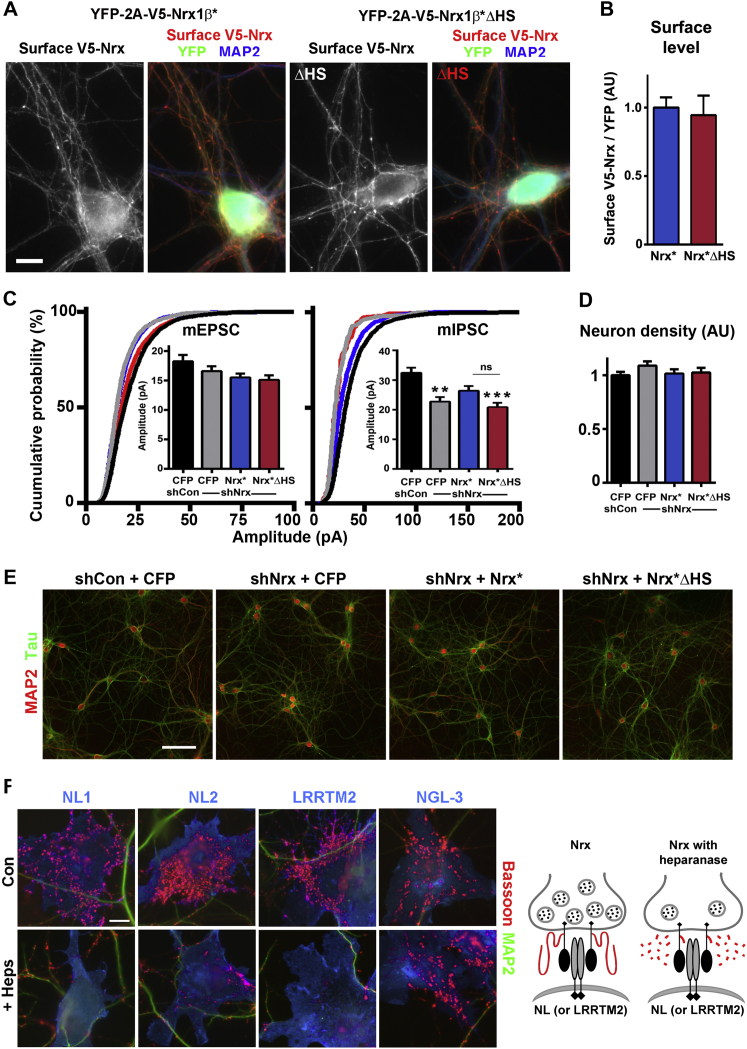
Nrx HS Modification Does Not Affect Nrx Surface Trafficking or Neuron Survival, and Heparinase Reduces Presynaptic Differentiation, Related to Figures 2 and 3(A) Nrx1β∗ΔHS reaches the axon surface, like Nrx1β∗, as shown by surface labeling of the V5 tagged Nrx constructs co-expressed with YFP through a 2A peptide. Note that both Nrx1β∗ and the ΔHS mutant are primarily axonal as MAP2 positive dendrites show little V5 fluorescence.(B) The axon surface level of Nrx1β∗ΔHS was indistinguishable from that of Nrx1β∗. Ratios of surface V5 to total YFP were assessed along axons of 13 DIV neurons co-expressing the V5 tagged Nrx constructs with YFP linked through the 2A peptide. A Mann-Whitney test showed no significant difference, n = 21-22 cells from 2 independent experiments.(C) mEPSC amplitude was not significantly different among groups (p = 0.0591). The numbers of cells were: CFP+shCon (n = 21); CFP+shNrx (n = 32); Nrx∗+shNrx (n = 29); Nrx∗ΔHS+shNrx (n = 32) from 4 independent experiments. mIPSC amplitude was reduced by Nrx knockdown and partially rescued by RNAi-resistant Nrx∗ but not Nrx∗ΔHS. The numbers of cells were: CFP+shCon (n = 20); CFP+shNrx (n = 18); Nrx∗+shNrx (n = 18); Nrx∗ΔHS+shNrx (n = 18) from 3 independent experiments. ∗∗p < 0.01 and ∗∗∗p < 0.001 by Kruskal-Wallis and Dunn’s tests compared to shCon+CFP. For the experiments shown here and in Figure 2, neurons were transfected at plating with the rescue constructs, exposed to knockdown AAV vectors from 3 DIV and analyzed at 13 DIV (mIPSCs) or 14 DIV (mEPSCs).(D and E) Hippocampal neuron cultures immunolabeled for MAP2-positive dendrites and tau-positive axons appeared similar among all groups. Neuron density assessed as number of MAP2-positive neurons per coverslip area normalized to the shCon+CFP group did not differ among groups by Kruskal-Wallis, n = 30 from 3 independent experiments. Neurons analyzed here were from the same experiments as for Figures 2, 3D-3E and panel C in this figure. Neurons were transfected at plating with the rescue constructs, exposed to knockdown AAV vectors from 3 DIV and analyzed at 14 DIV.(F) Clustering of presynaptic marker bassoon in contacting axons induced by NL1, NL2, or LRRTM2 on COS7 cells, but not by NGL-3 a ligand of type IIA protein tyrosine phosphatases, was reduced by heparinase (Heps). Co-labeling for the microtubule associated protein 2 (MAP2) identified dendrites to exclude native synapses from the analysis. Heparinase was added after axon outgrowth only during the co-culture period. For quantitation, see Figure 3C.Error bars represent SEM. Scale bars, (A) 10 μm, (E) 10 μm, (F) 100 μm.